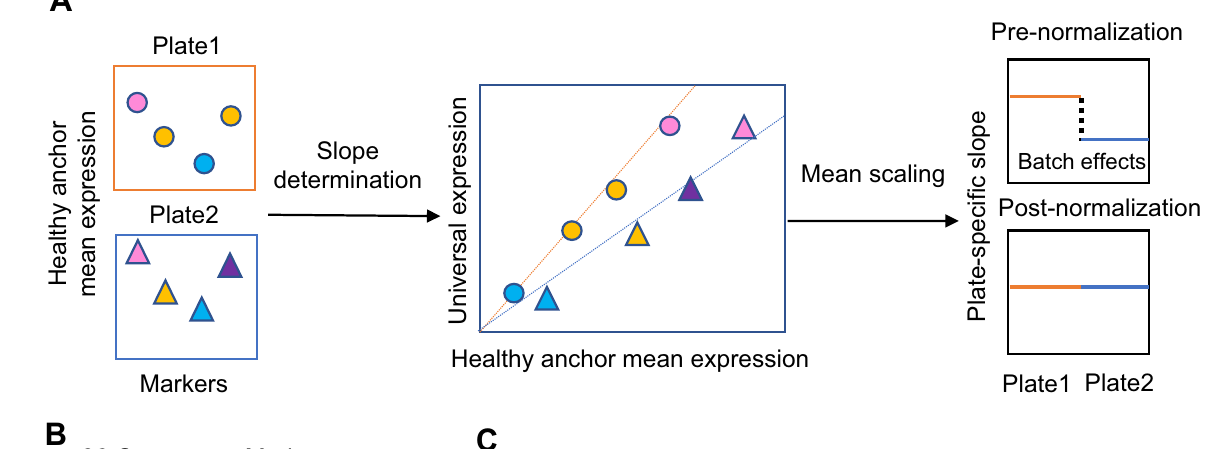
We compared our batch normalization approach to two existing mass cytometry normalization methods, CytoNorm (CN) and CytofRUV (CV), and Seurat (ST), a batch correction method for scRNA-seq (Supplementary Figs. 6 and 7) 18,28,29 . CN and CV rely on identical anchors, thus we made the assumption that the healthy anchors from each batch are approximately identical